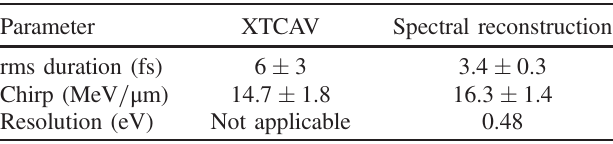
TABLE V. Comparison of measurements from the XTCAV with our reconstruction for the larger chirp case. The SASE bandwidth was estimated in the text as 5 eV. The uncertainties in the reconstructed values reflect a (cid:3) 0 . 5 eV assumed uncertainty in the SASE